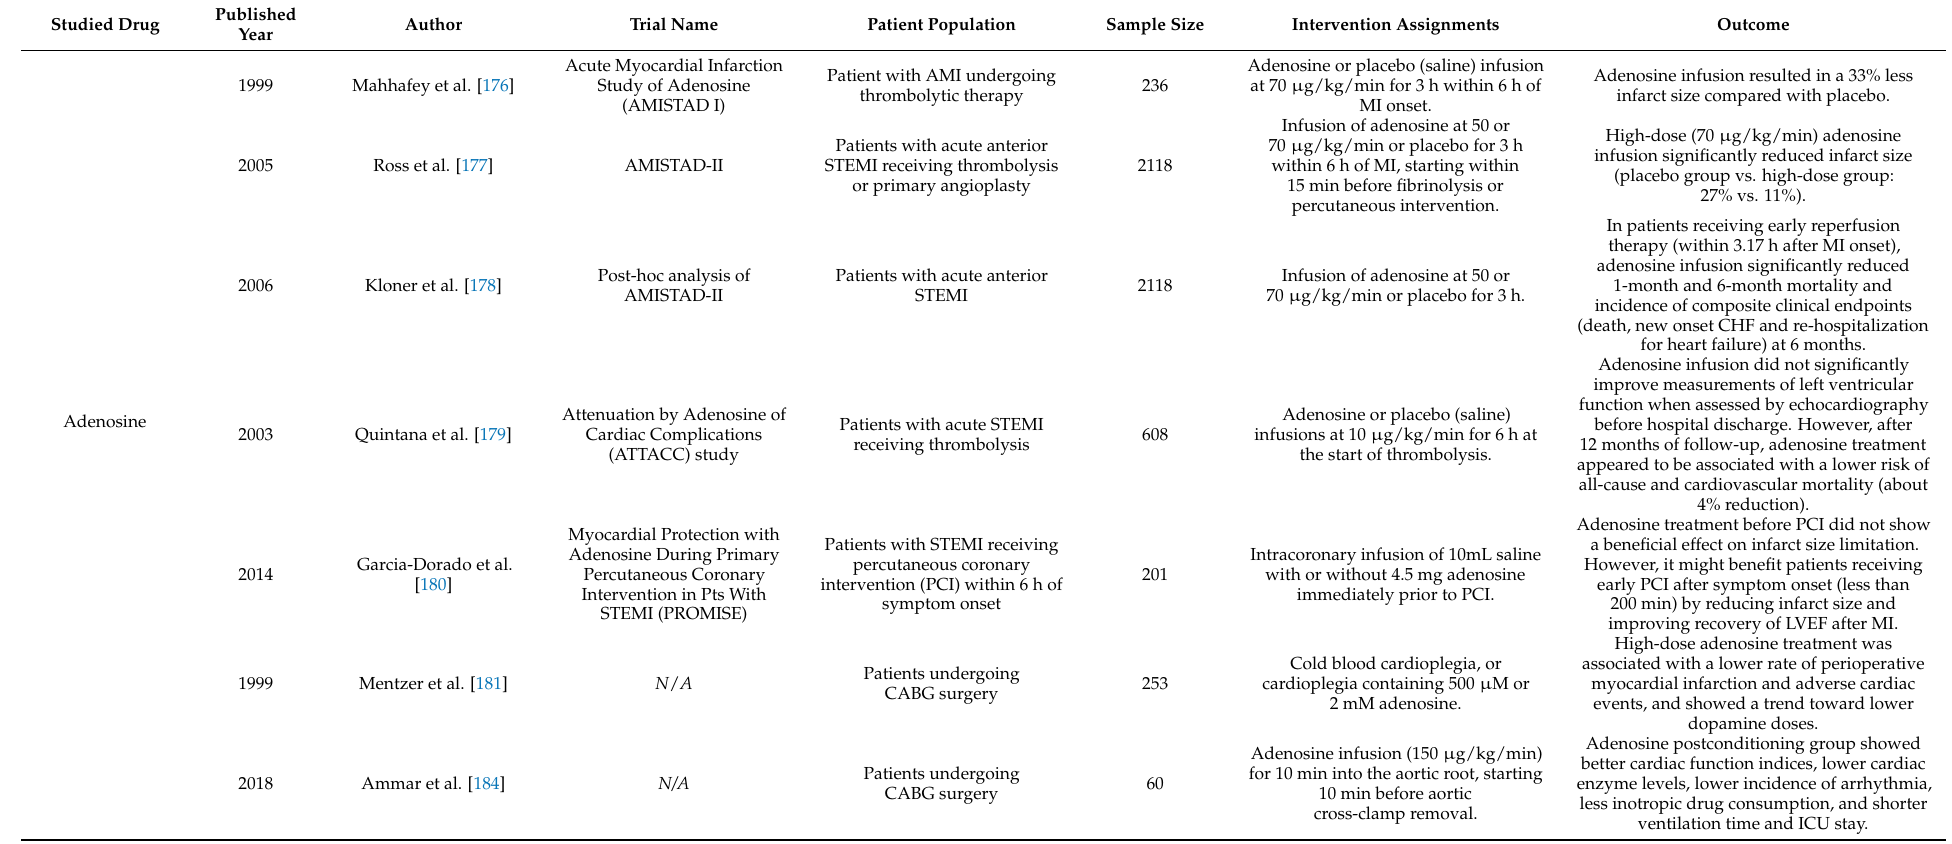
Table 1. Summary of the cardiovascular outcomes in selected clinical trials of drugs targeting different steps of the adenosine